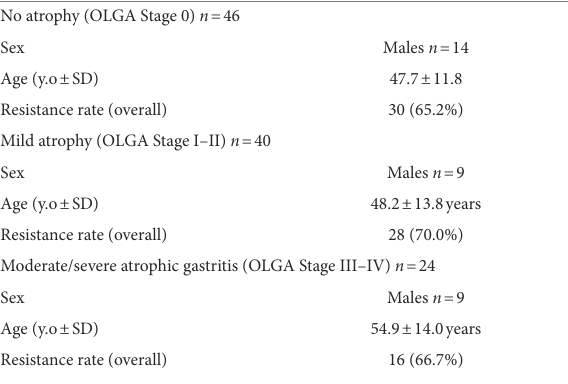
H. pylori was detected in the antrum of 96.2% of patients, in the corpus of 92.5% of patients, and both in antrum and corpus in 88.7% of the patients. Among patients included in Group 1 (no atrophy OLGA 0, n = 46, 14 males, mean age 47.7 ± 11.8 years), 30 patients had at least one antibiotic resistance (overall resistance rate 65.2%) and in the antrum and in the corpus. Resistance against clarithromycin